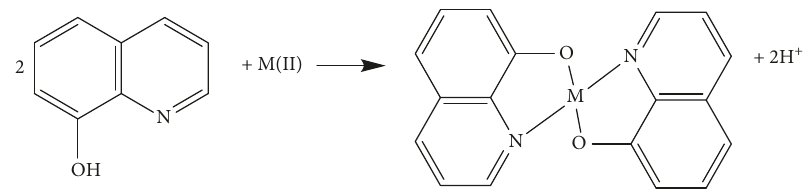
Figure 3: Complexing reaction between metal (M) and